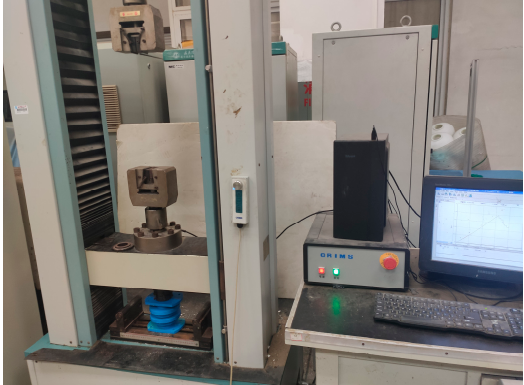
Figure 10. Electronic universal testing machine.